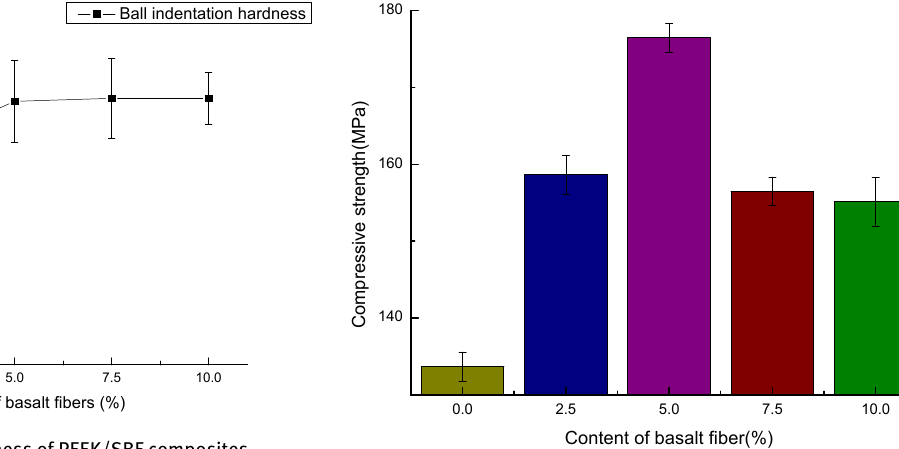
Figure 2: Ball indentation hardness of PEEK/SBF composites